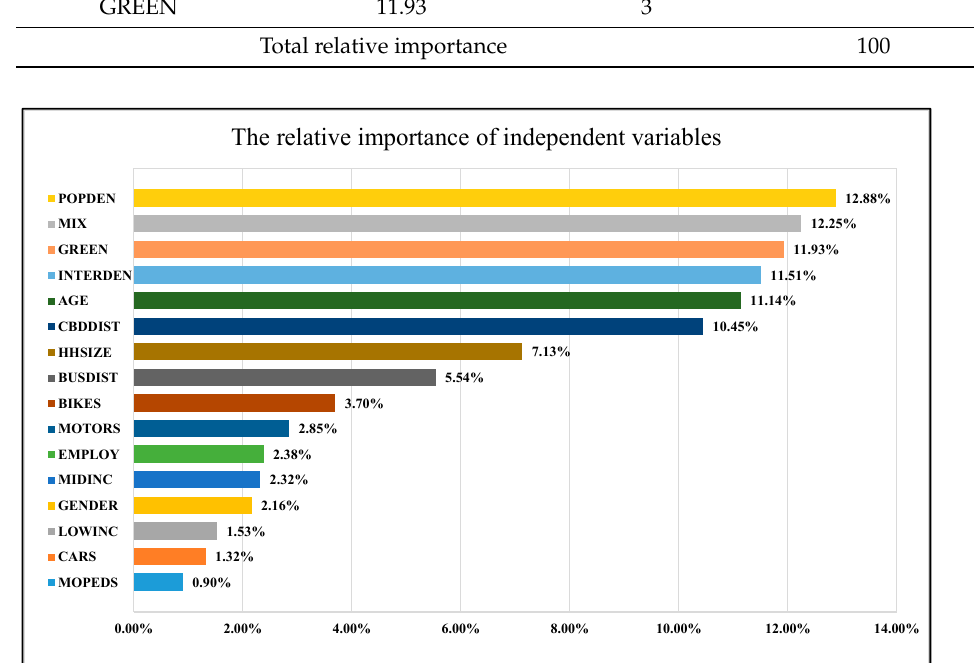
Figure 2. The ranking of the relative importance of independent variables.